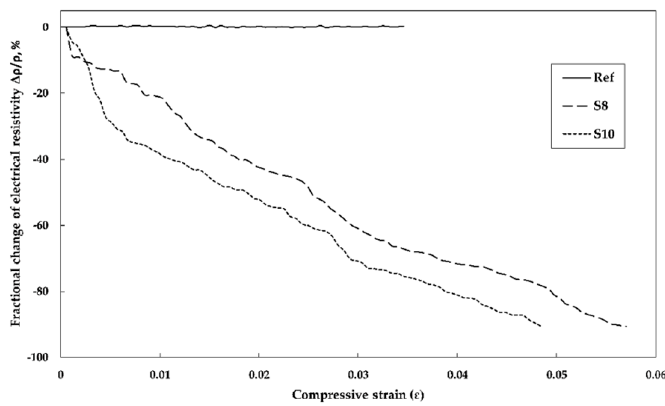
Figure 13. Relationship between fractional change in electrical resistivity and compressive strain.